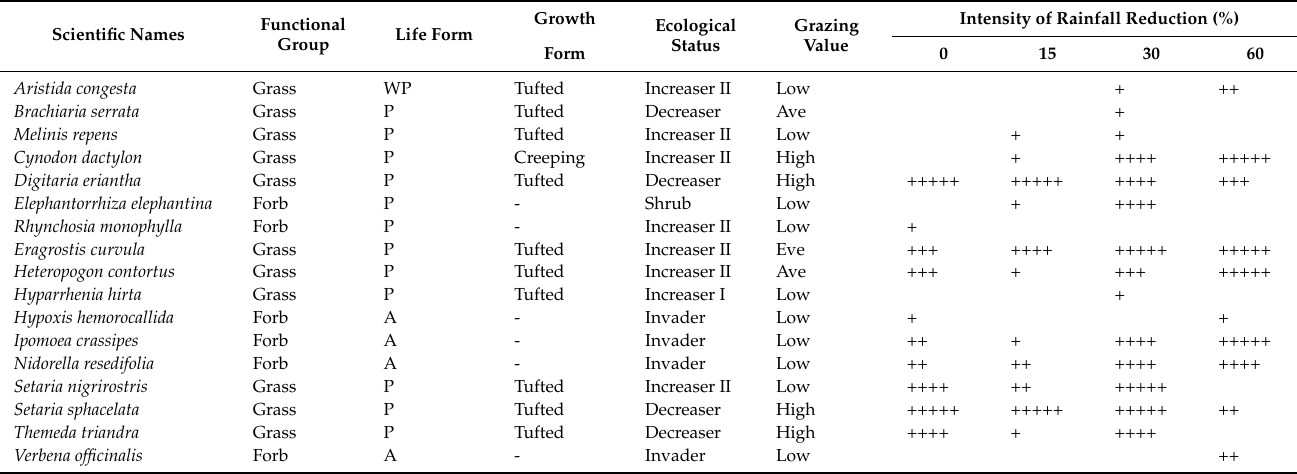
Table 1. Ecological status, presence or absence and level of occurrence of grass/forb species in the various plots subjected to different intensities of rainfall reduction at the University of Pretoria experimental farm.